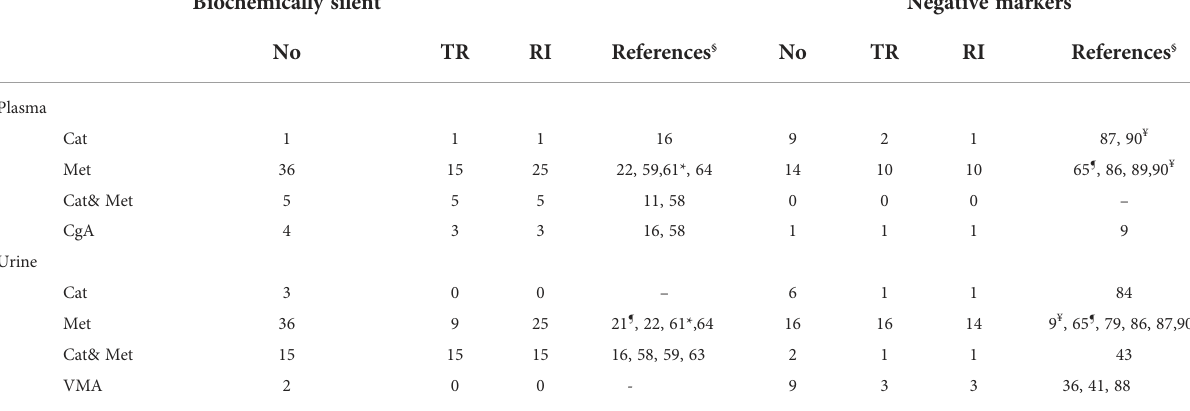
TABLE 2 Biochemical tests in patients according to authors ’ classi fi cation of catecholamine biochemical